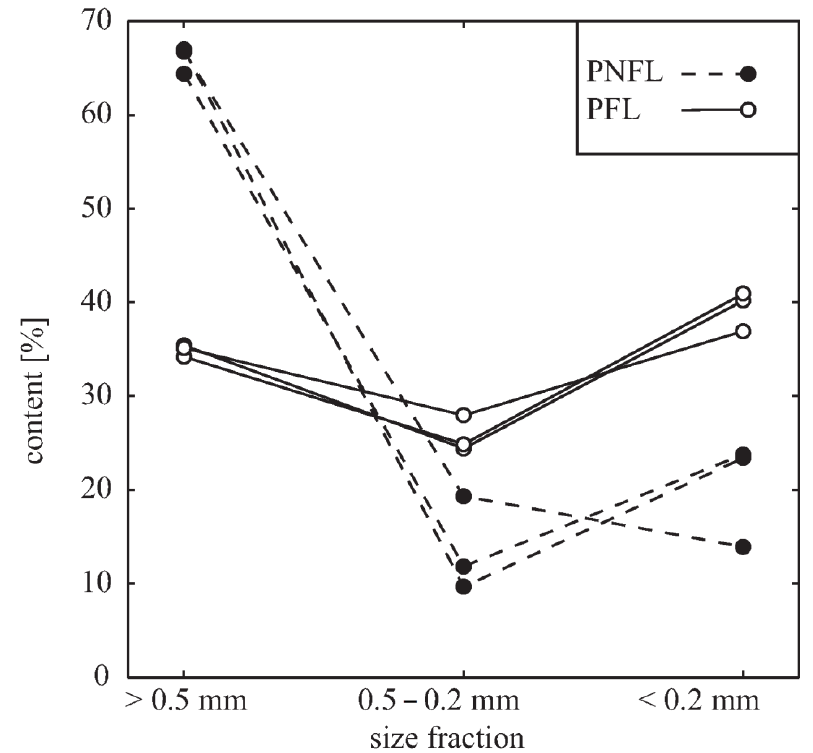
Figure 5. Contribution of various size fractions [ w / w ] in PFL- and PNFL-MO samples.